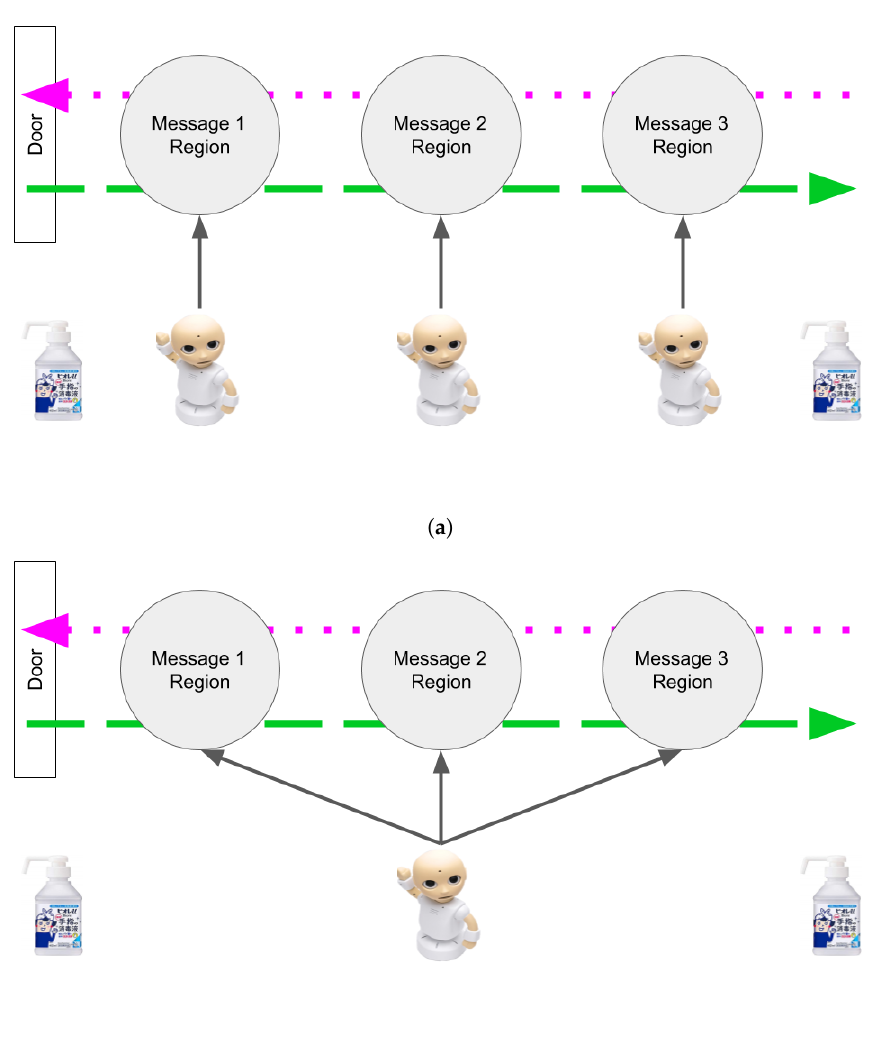
Figure 8. Diagram indicating the “Going In” (green, dashed) and “Going Out” routes (magenta, dotted), and the approximate region in which, after the participant entered, the operator activated the corresponding robot: ( a ) 3 robots ( b ); 1 robot . Note: Regardless of the configuration, the regions and timing of the message remained the same, with the only difference being that in the one-robot configuration, the solo robot was activated in all regions.